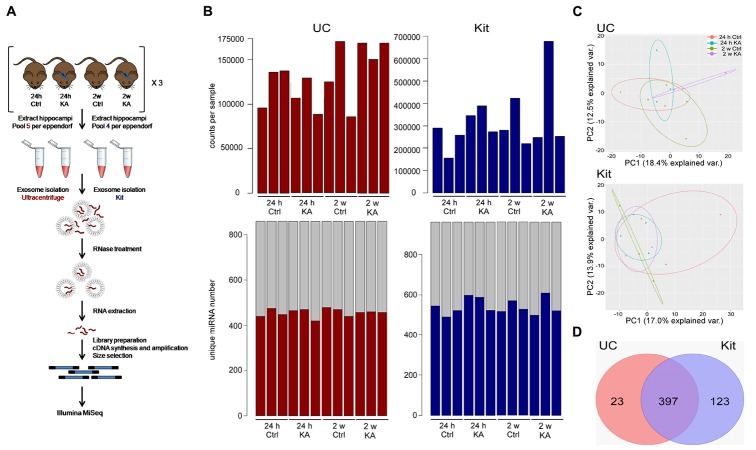
Study design and sequencing of EEF miRNAs. (A) Schematic of experimental design for miRNA sequencing. EEFs were prepared using hippocampi from sets of control (Ctrl) or KA-treated mice using UC- or kit-based methods. EEFs were then RNAse treated to remove non-enclosed miRNAs and processed for RNA sequencing. (B) Top: bar plot showing total number of counts per sample mapping to miRBase_V21. Bottom: Number of confidently called, unique miRNA identified in each sample. (C) Principal component analysis (PCA) plot showing clustering of the 420 and 520 filtered miRNAs from UC and kit samples, respectively. (D) Venn diagram shows the number of detected miRNAs in exosomes post filtration in UC and in kit, highlighting EEF miRNAs common to both methods.